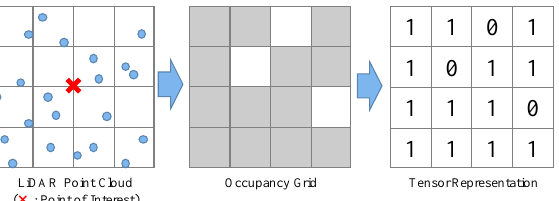
Figure 1. Occupancy Grid and Tensor Representation